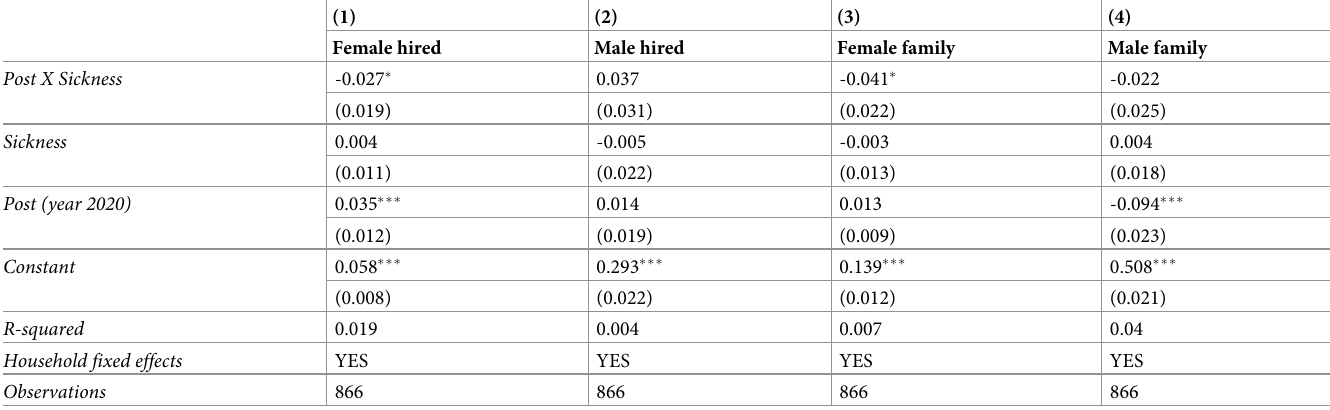
Table 5. Regression results for COVID-19 effects on labor allocation